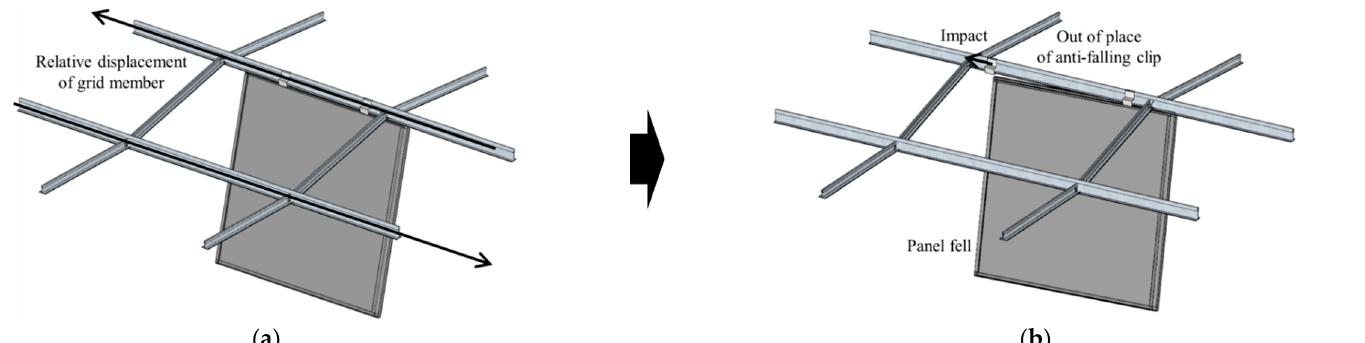
Figure 18. Cause of damage for the panel falling. ( a ) Panel dislodged and hanging because of the relative displacement of the grid member. ( b ) Failure of the anti-falling clip due to the impact.